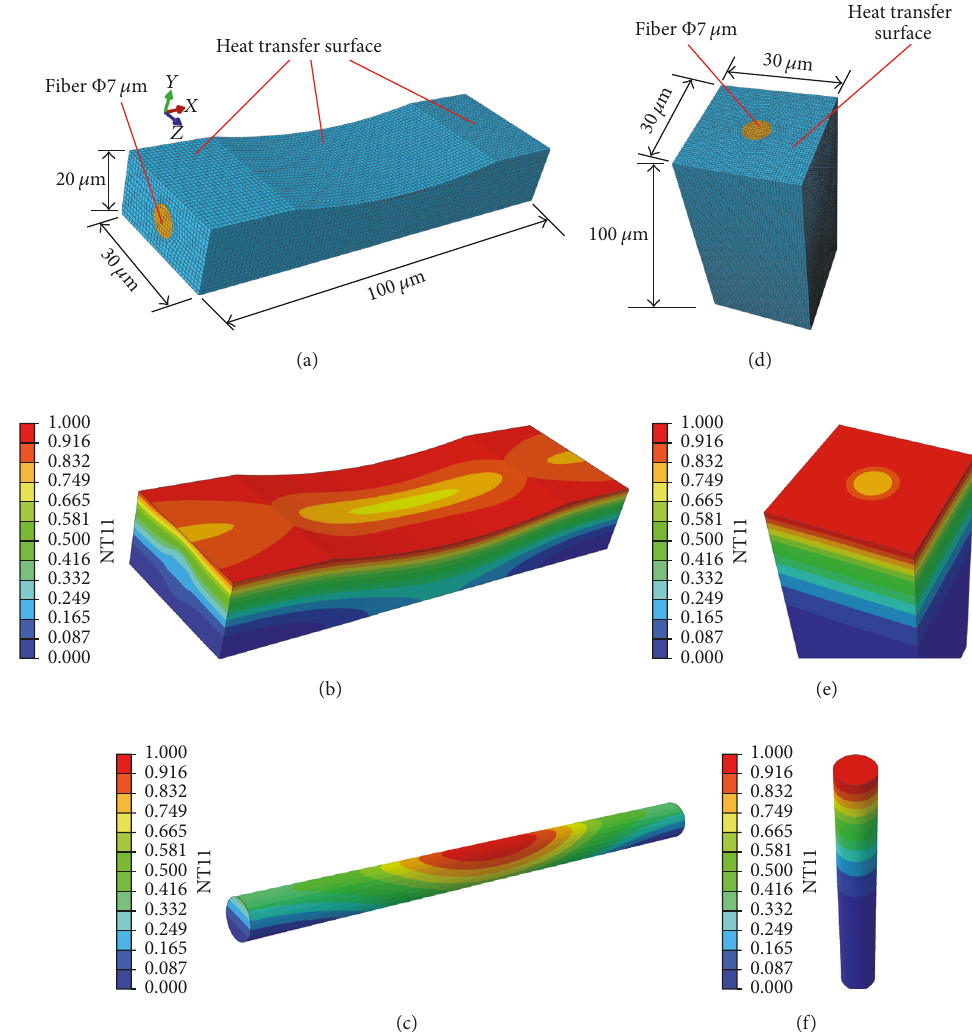
Figure 6: Numerical simulation of the C/C composites with a single paralleled (Direction I) and a single perpendicular fiber (Direction II), respectively: (a) and (d) are geometrical dimensions; (b) and (e) are overall temperature field; (c) and (f) are temperature field of the fiber bundle (note that the temperature contours are plotted in dimensionless units, where temperature value of 0 refers to the lowest temperature and value of 1 denotes the highest